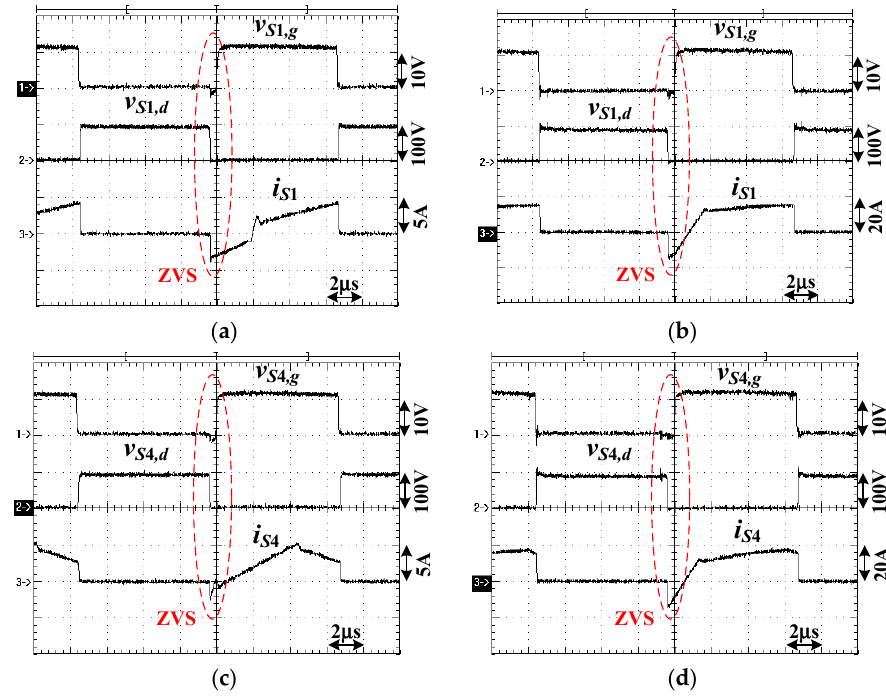
Figure 10. Measured results of S 1 and S 4 at V in = 90 V input ( a ) S 1 waveforms at 160 W (20% load)